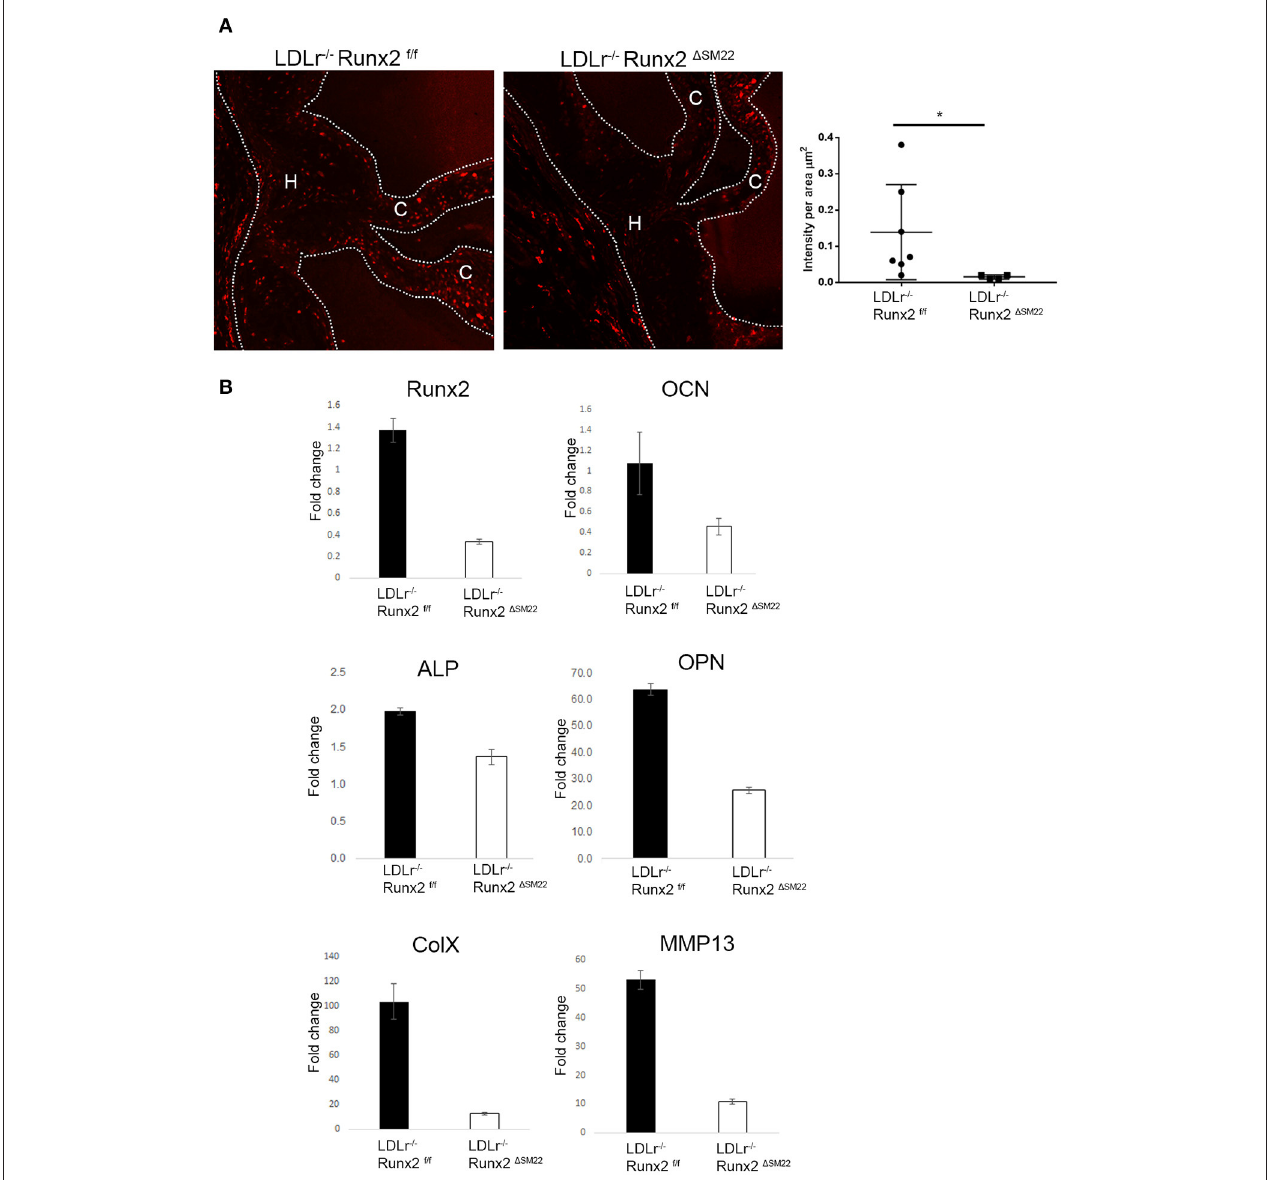
FIGURE 2 | Runx2 in SM22 α + VICs and sinus wall cells contributes to osteochondrogenic differentiation in the aortic valve. (A) LDLr − / − :Runx2 1 SM22 mice and LDLr − / − :Runx2 f / f littermates were fed with a T2DM diet for 26 weeks. Aortic valves (dashed lines) were collected for Runx2 immunofluorescent staining. Graphs show the quantification of Runx2 intensity in leaflets (cusp + hinge) normalized to the area. (B) LDLr − / − :Runx2 f / f and LDLr − / − :Runx2 1 SM22 mice were fed with T2DM for 26 weeks. Four to ten aortic valves were pooled to generate RNA. Runt-related transcription factor 2, osteocalcin (OCN), alkaline phosphatase (ALP), osteopontin (OPN), and chondrocyte markers, Collagen X (ColX), and MMP13, gene expression was determined in triplicate via real-time quantitative PCR (qRT-PCR). Differences between groups were analyzed by student’s t -test. * p < 0.05. Data shown are mean ± SD. C, Cusp; H,